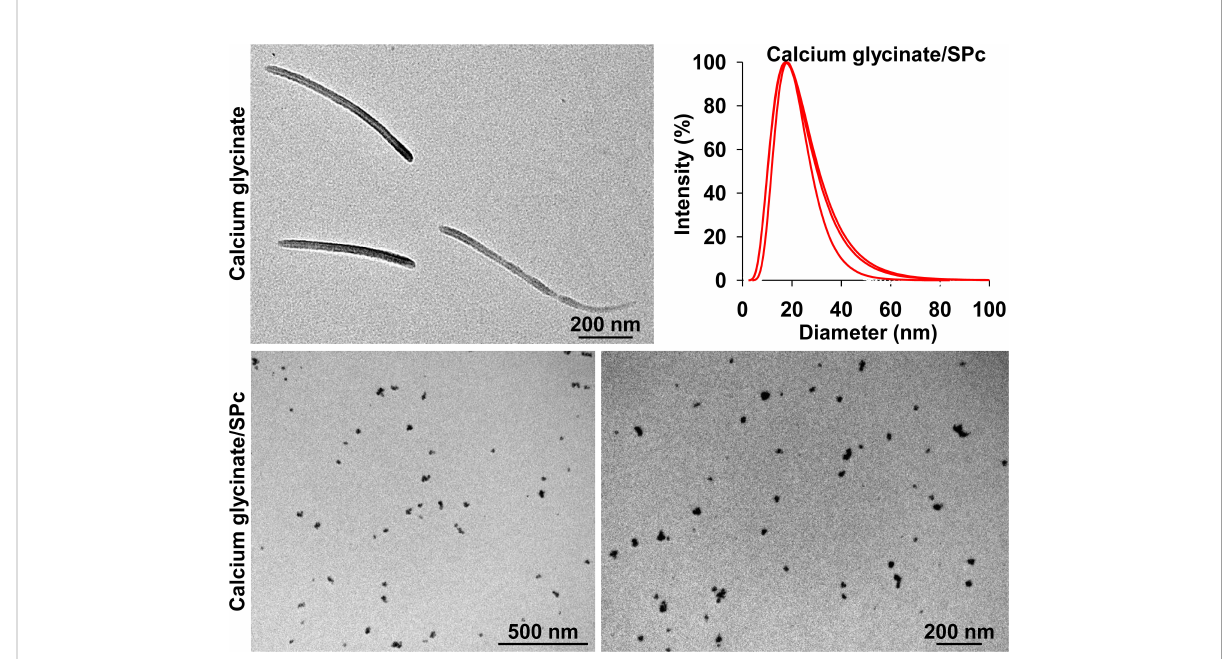
FIGURE 2 Transmission electron microscope image and particle size distribution of calcium glycinate/SPc complex at the mass ratio of 1:8.8.